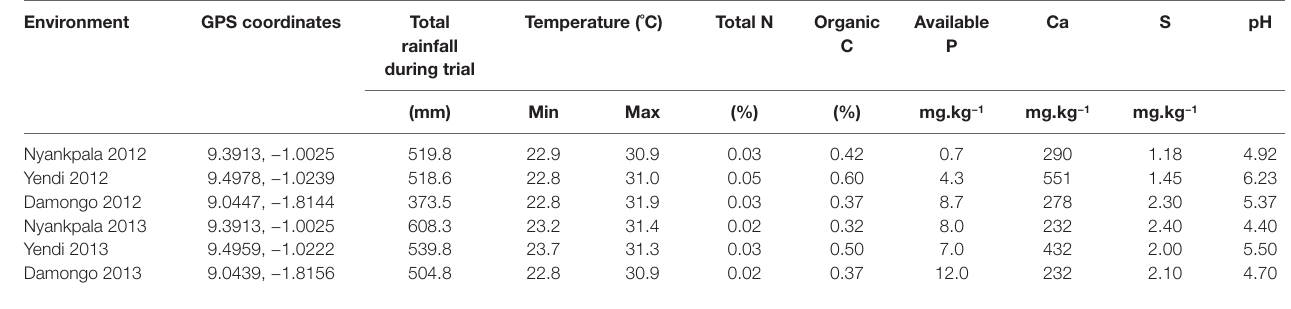
TABLE 1 | Environmental and soil characteristics of sites used in this study.